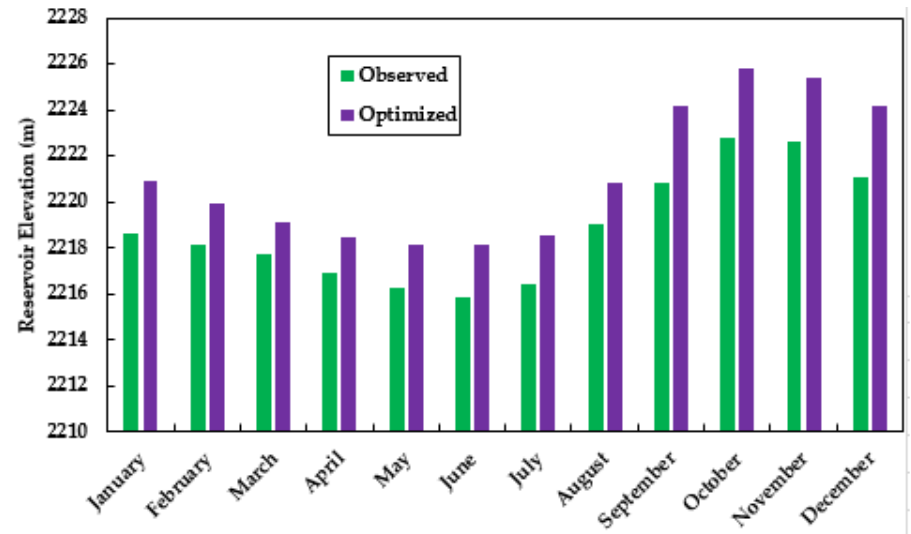
Figure 7. Average monthly current observed and optimized power storage of the Nashe reservoir.